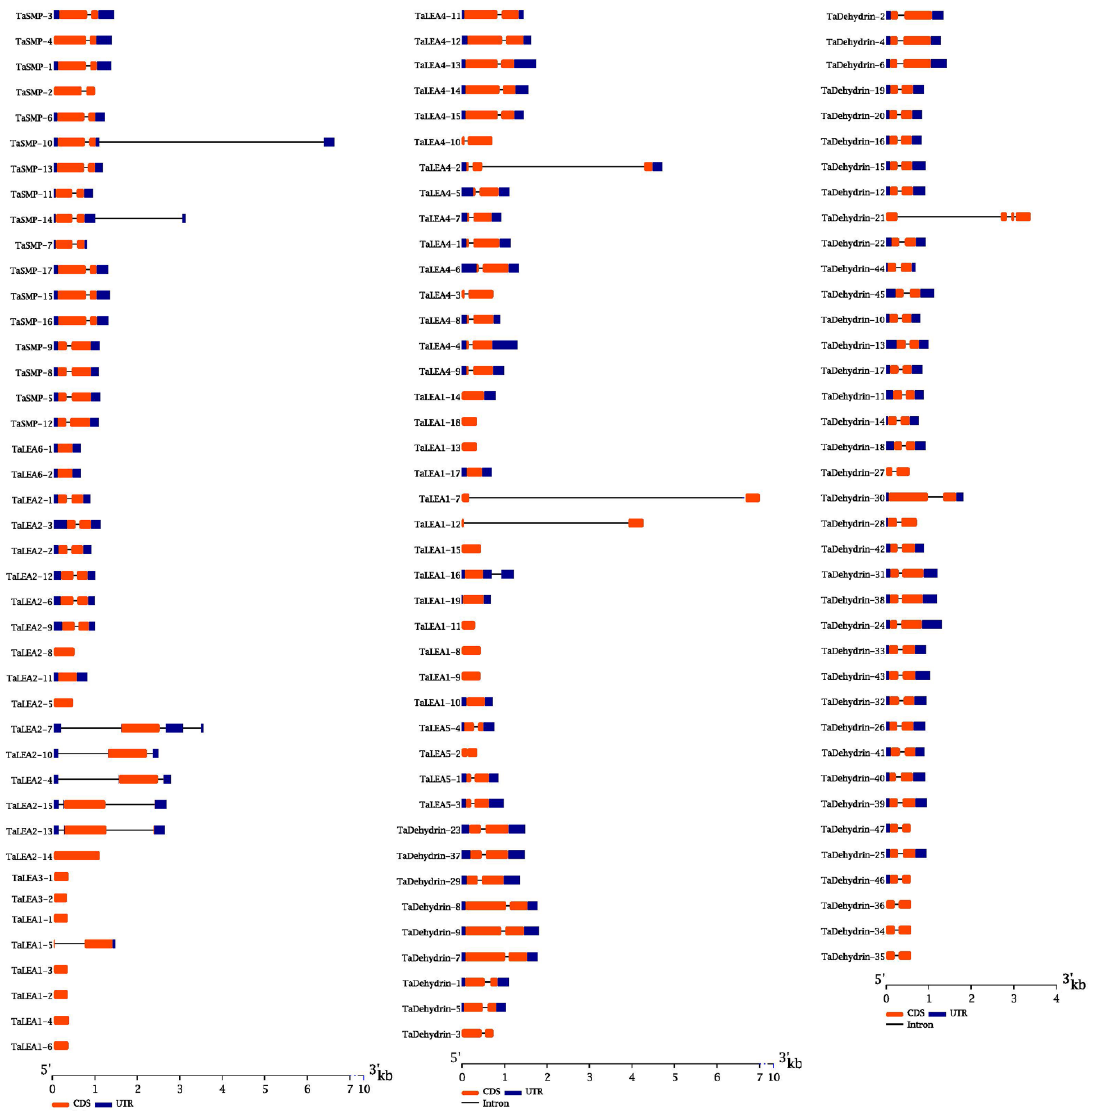
Figure 2. Exon-intron structures of TaLEA genes. Exon-intron are indicated by wide color bar and black line, respectively.